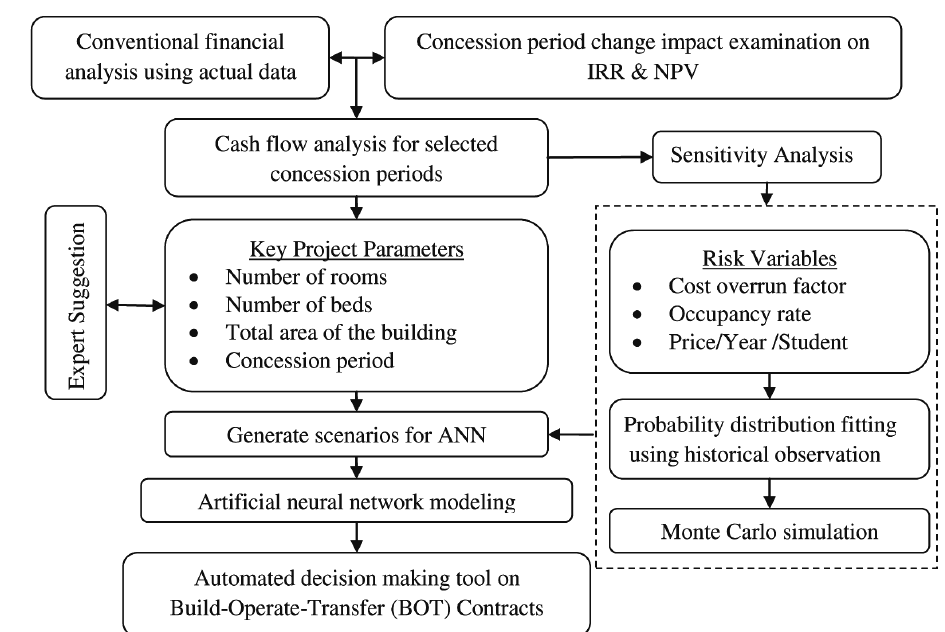
Fig. 2. Sampling procedure for ANN